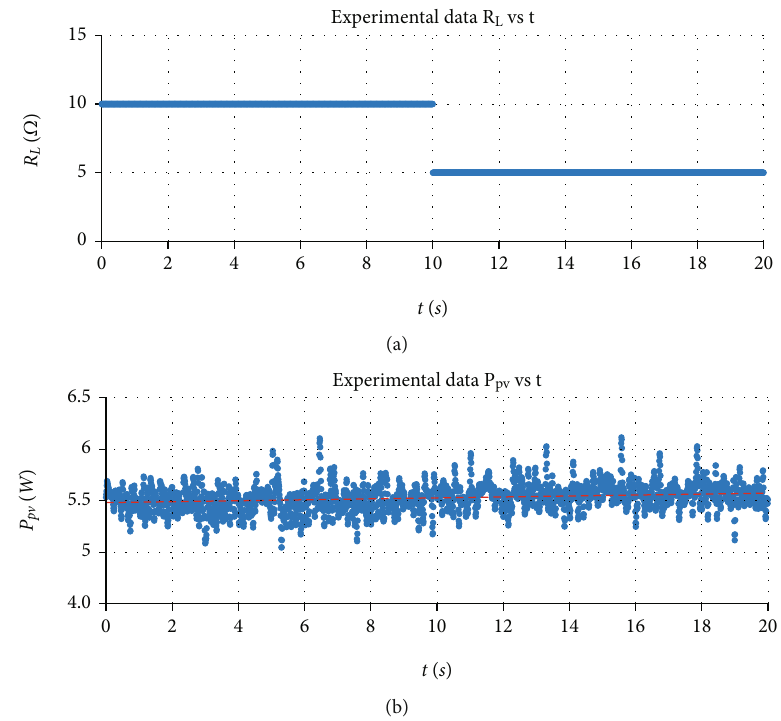
Figure 11: Experimental data of the PV cell output power response to a given step of the output load at a constant sun irradiation power ≈ 970W/m 2 , with the IDA-PBC strategy implemented into a hardware platform. (a) R G sun with the IDA-PBC strategy. output power response P pv